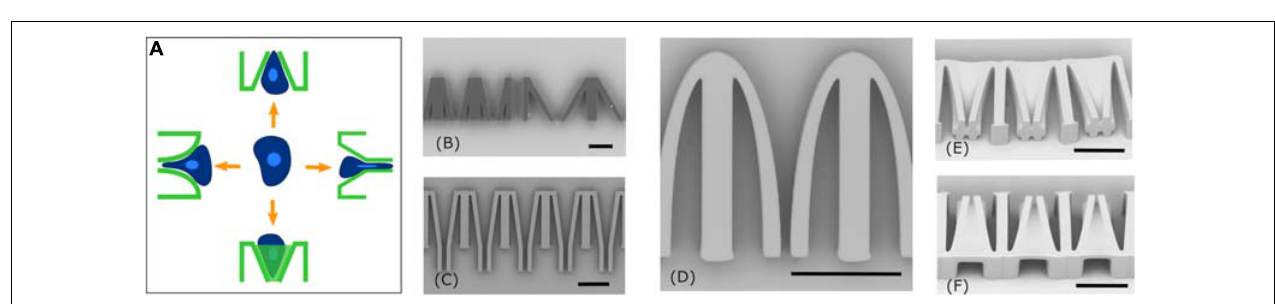
FIGURE 3 | (A) Picture of whole device ready with blow up (B) of a microscope image of the constriction region. In the scheme, the sample deposition chamber and the chemoactractor chamber are labeled as S and C, respectively.